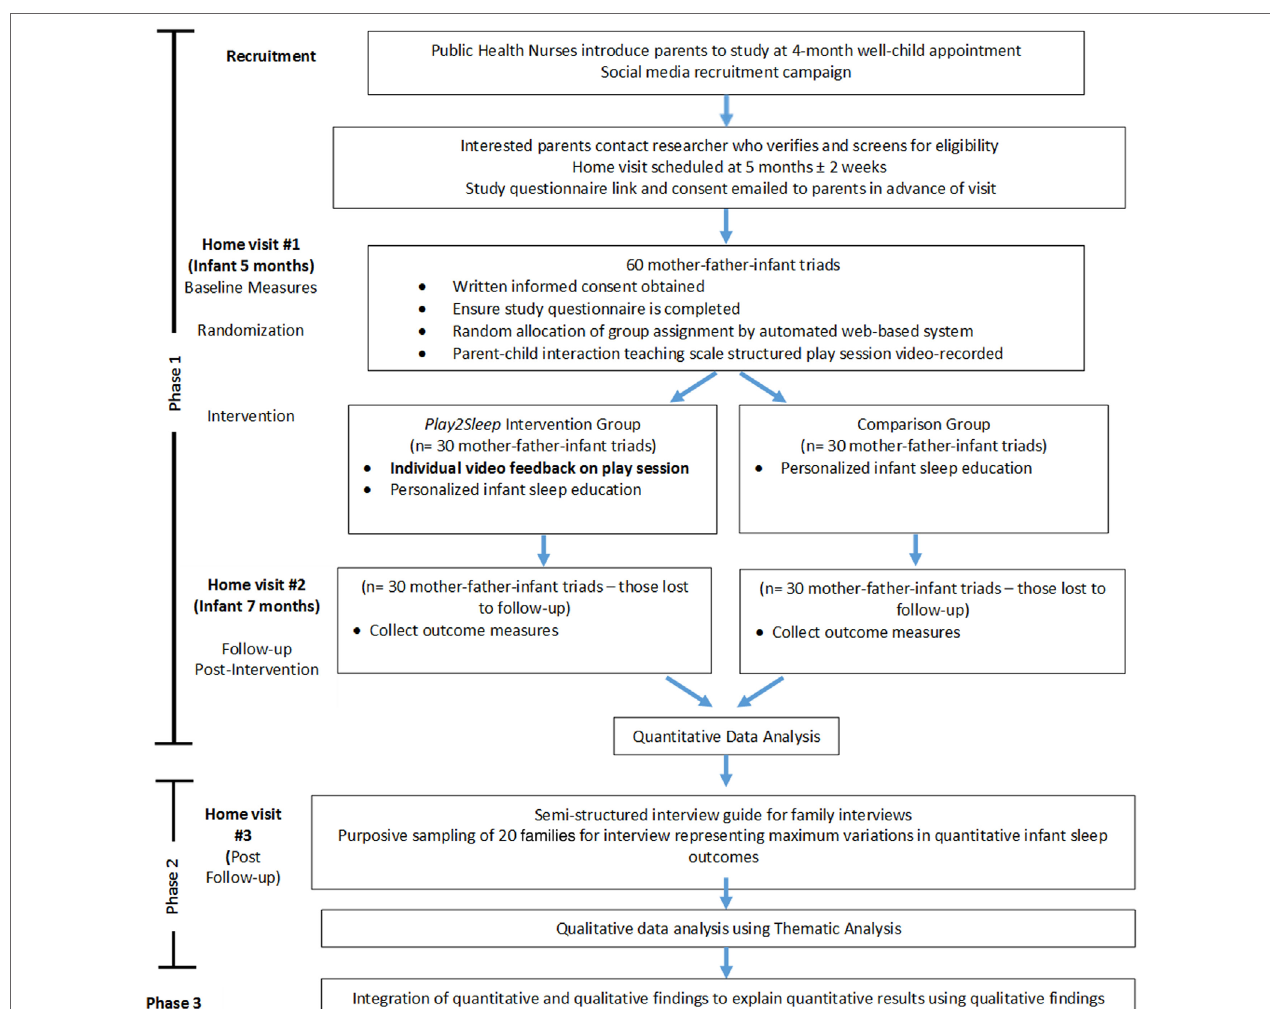
FigurE 1 | Flow chart of the